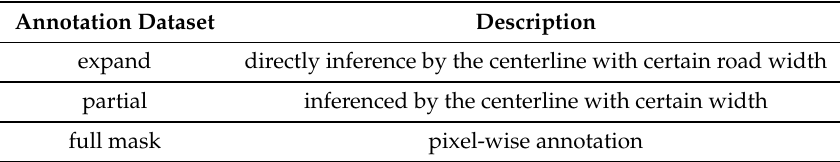
Table 2. Different annotation